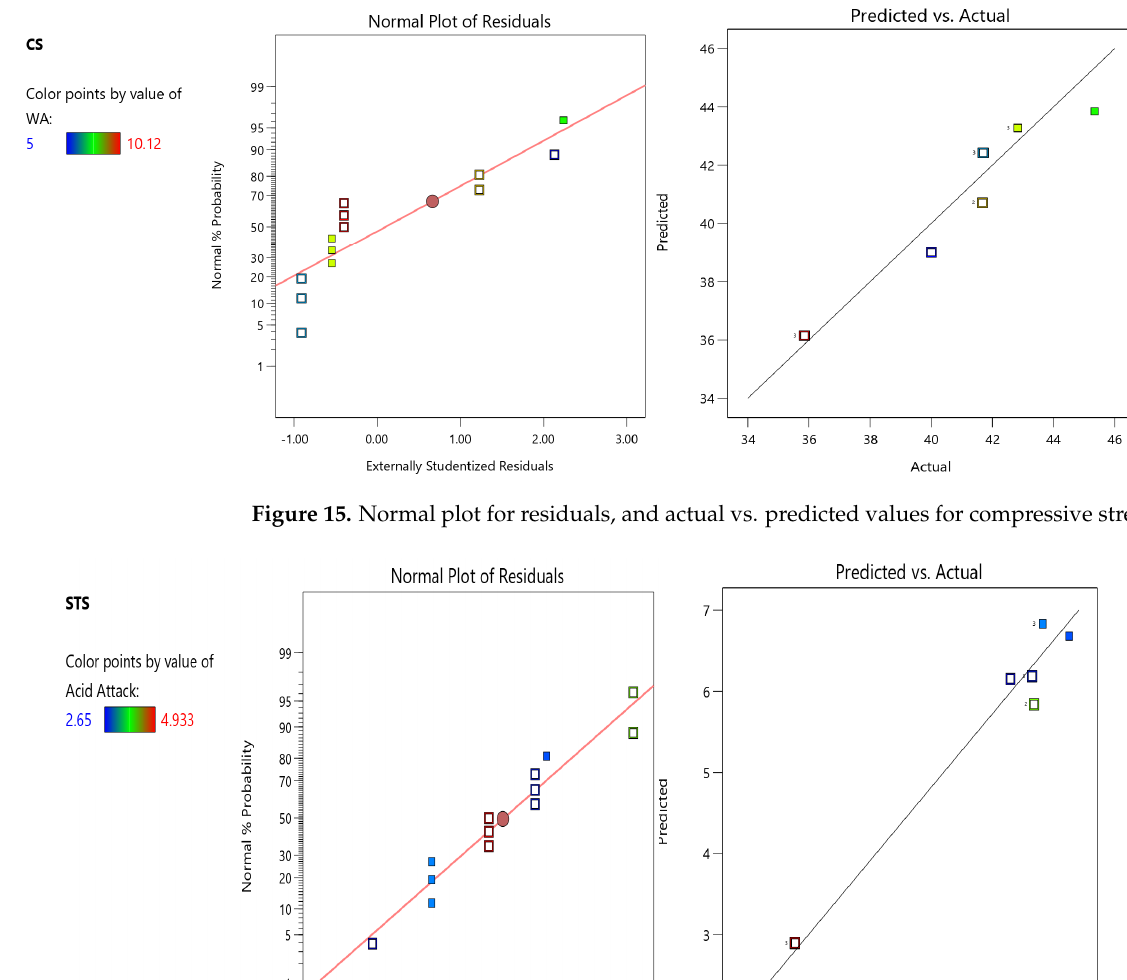
Figure 14. Normal plot for residuals, and actual vs. predicted values for L-Box test.